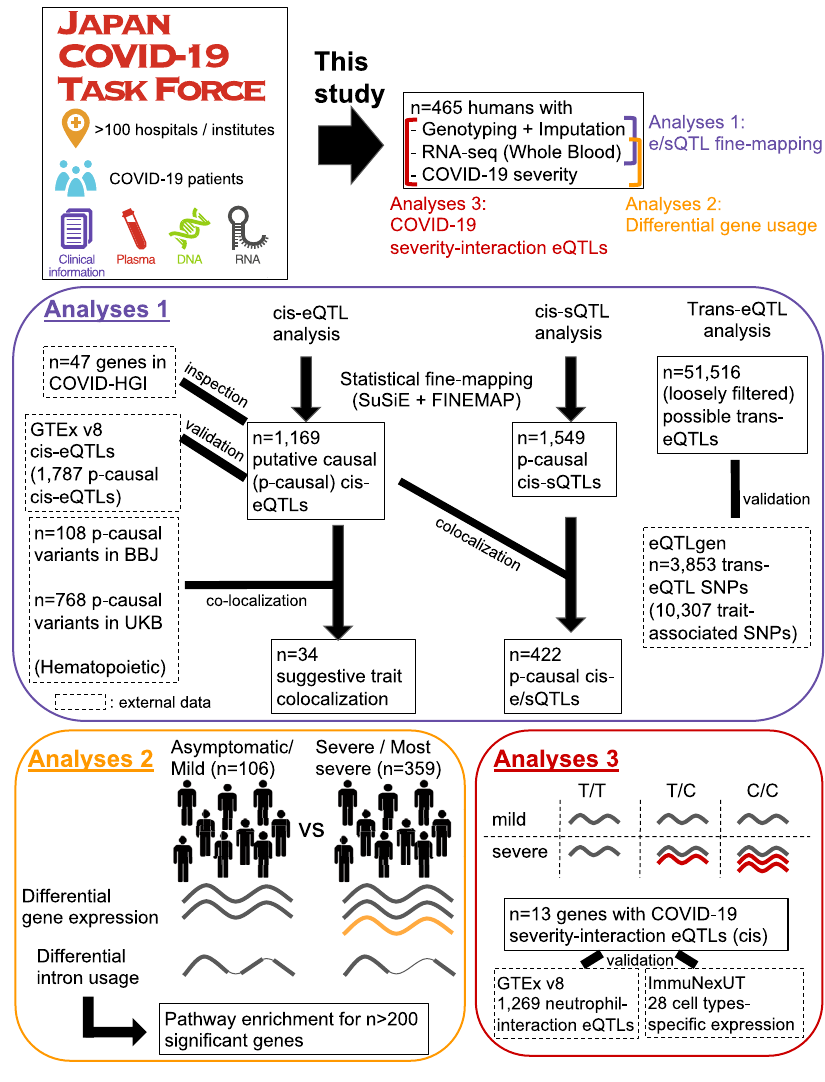
Fig. 1 | Overview of the study. Japan COVID-19 Task Force (JCTF) has collected DNA, RNA, and plasma from COVID-19 cases along with detailed clinical informa- tion.Asubsetof n =500( n =465afterQC)harboringRNA-seqdatawasanalyzedin this study. COVID-19 disease severity was used together with RNA-seq data to